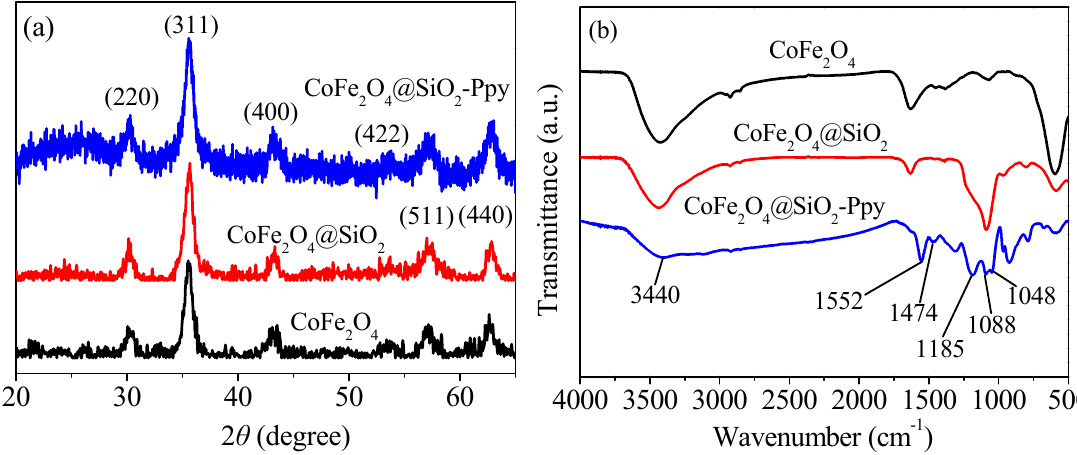
Figure 6. X-ray diffraction (XRD) images ( a ) and Fourier transform infrared (FT-IR) spectra ( b ).